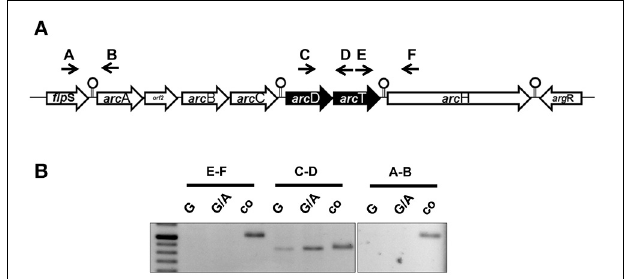
FIGURE 1 | The S. suis ADS is transcribed in five transcriptional units. (A) Schematic representation of the ADS of S. suis . Genes are depicted as arrows pointing toward their transcriptional orientation. Intergenic primers were enumerated with capitals. Stemloop structures separate single transcriptional units. (B) Semi-quantitative RT-PCR analysis of S. suis WT strain 10 grown in a tryptone-based medium supplemented with 10mM glucose (G) or 10mM galactose (G/A) and 50mM arginine, respectively. Chromosomal DNA was used as positive control. Capitals indicate the intergenic primers depicted in (A)